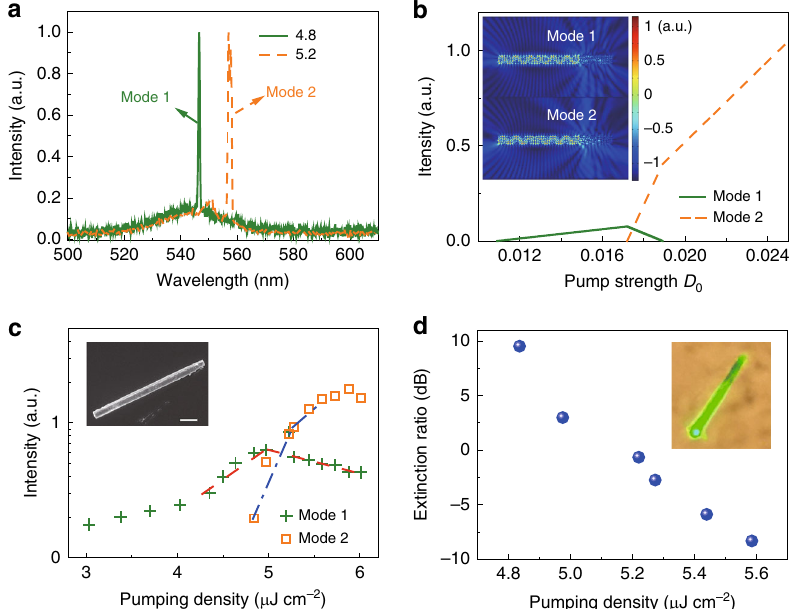
Fig. 5 Mode switching in a single perovskite microrod. a Lasing spectra at different pump intensities. b Numerical simulations of the mode switching. The parameters used here are: k a L = 114.3 and refractive index n = 2.56 – 0.001 i . The calculated self-interaction and cross-interaction coef fi cients are χ 11 = 1.2582 × 10 23 , χ 12 = 3.0256 × 10 22 , χ 21 = 3.0256 × 10 22 , and χ 22 = 1.0403 × 10 22 . The insets are the fi eld patterns of two high-Q resonant modes. c Output intensities of the two modes as a function of the pumping density. Inset: SEM image of the perovskite microrod. The length of scale bar is 5 μ m. d Extinction ratio as a function of the pumping density. Inset: Fluorescent microscope image of the